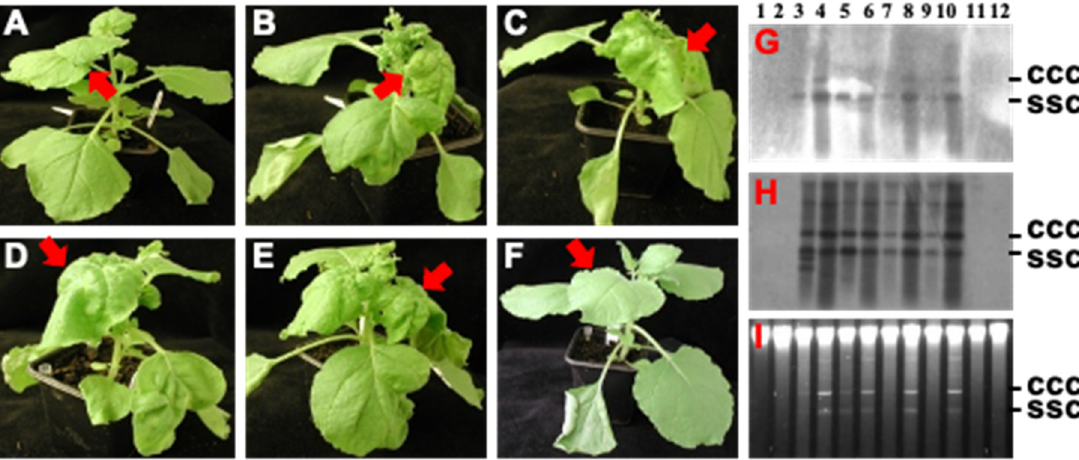
Figure 4. Threshold effect of hotspot siRNA on ACMV infection. ( A – F ) Plant infections. N. benthamiana plants were mock-inoculated ( A ), or inoculated with ACMV [500 ng of pCLV1.3A (DNA-A) and 500 ng of pCLV2B (DNA-B)] plus 0 ( B ), 2.5 ( C ), 5.0 ( D ), 10.0 ( E ) and 20.0 ( F ) µg hotspot siRNA. Plants were photographed at 14 dpi. Typical ACMV symptoms including chlorosis and curling on systemic young leaves are indicated by arrows. Systemic healthy leaves in mock ( A ) and hotspot siRNA-protected ( F ) plants are also indicated. ( G – I ) Southern detection of viral DNA accumulation. DNAs were extracted from inoculated leaves ( G – I , lanes 1, 3, 5, 7, 9 and 11) and systemic young tissues ( G – I , lanes 2, 4, 6, 8, 10 and 12) of plants with mock inoculation (lanes 1 and 2) and of plants inoculated with ACMV plus 0 (lanes 3 and 4), 2.5 (lanes 5 and 6), 5.0 (lanes 7 and 8),